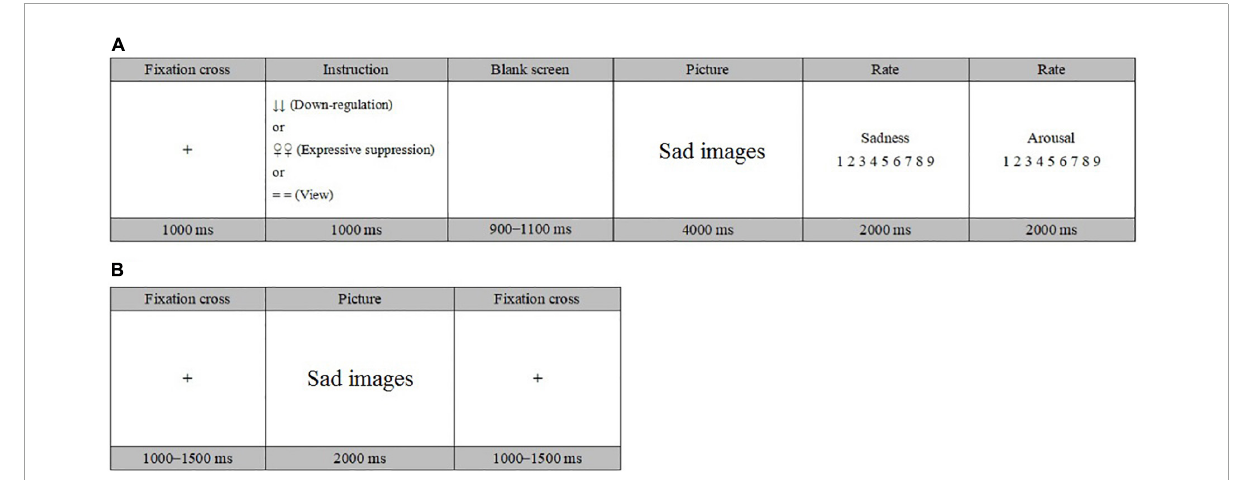
FIGURE1 Schematic representations of a trial in the regulation phase (A) and the test phase (B) .